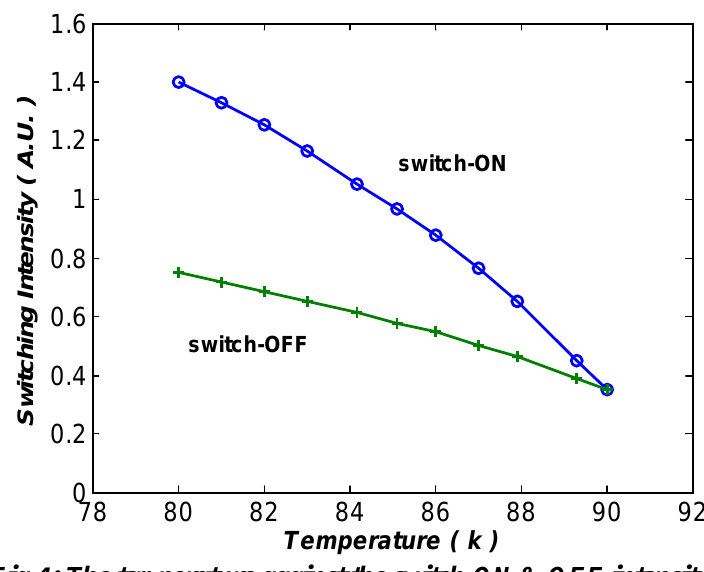
Fig.4: The temperature against the switch-ON & OFF